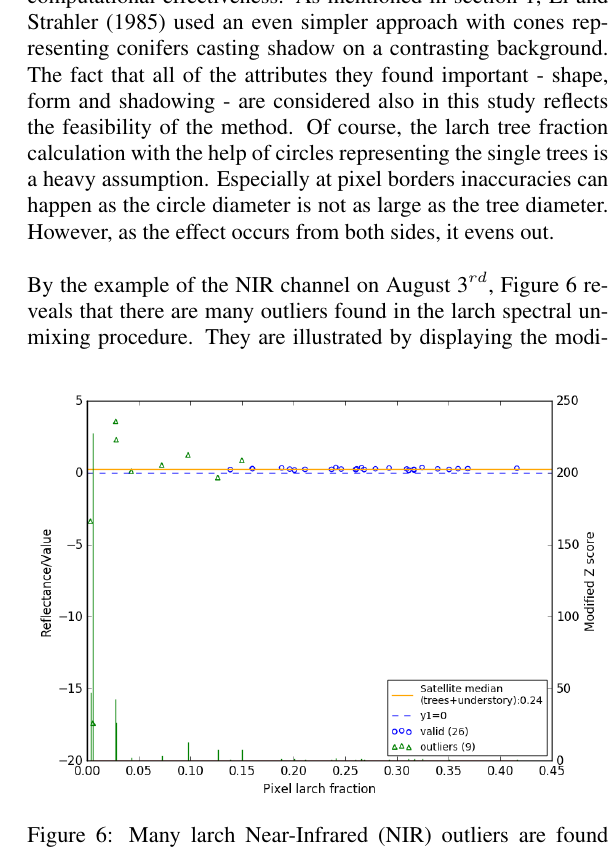
Figure 6: Many larch Near-Infrared (NIR) outliers are found when the pixel larch fraction is smaller than